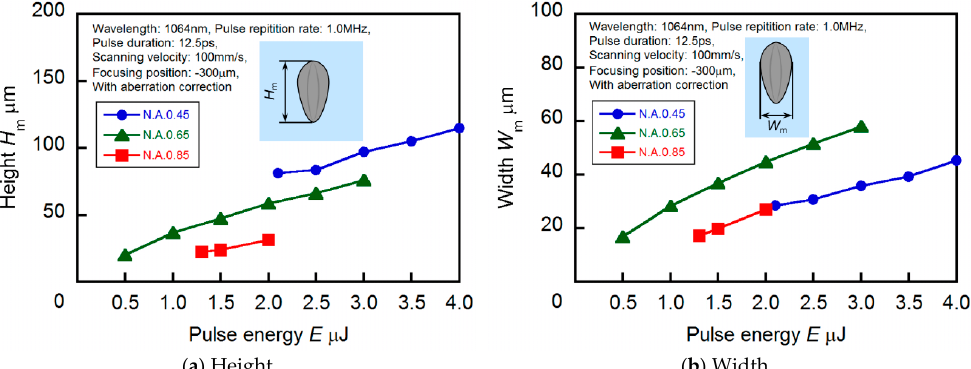
Figure 15. Influence of numerical aperture on size of molten area.